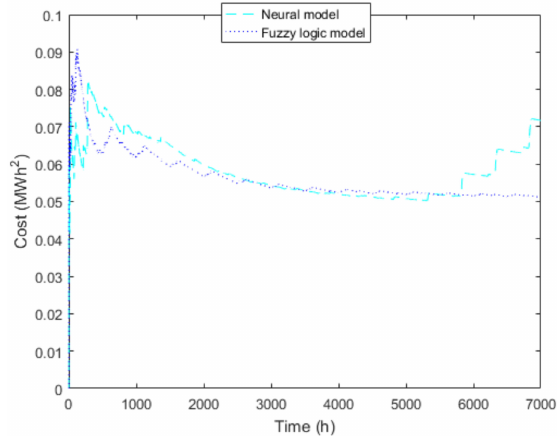
Figure 5. Training costs of the first training